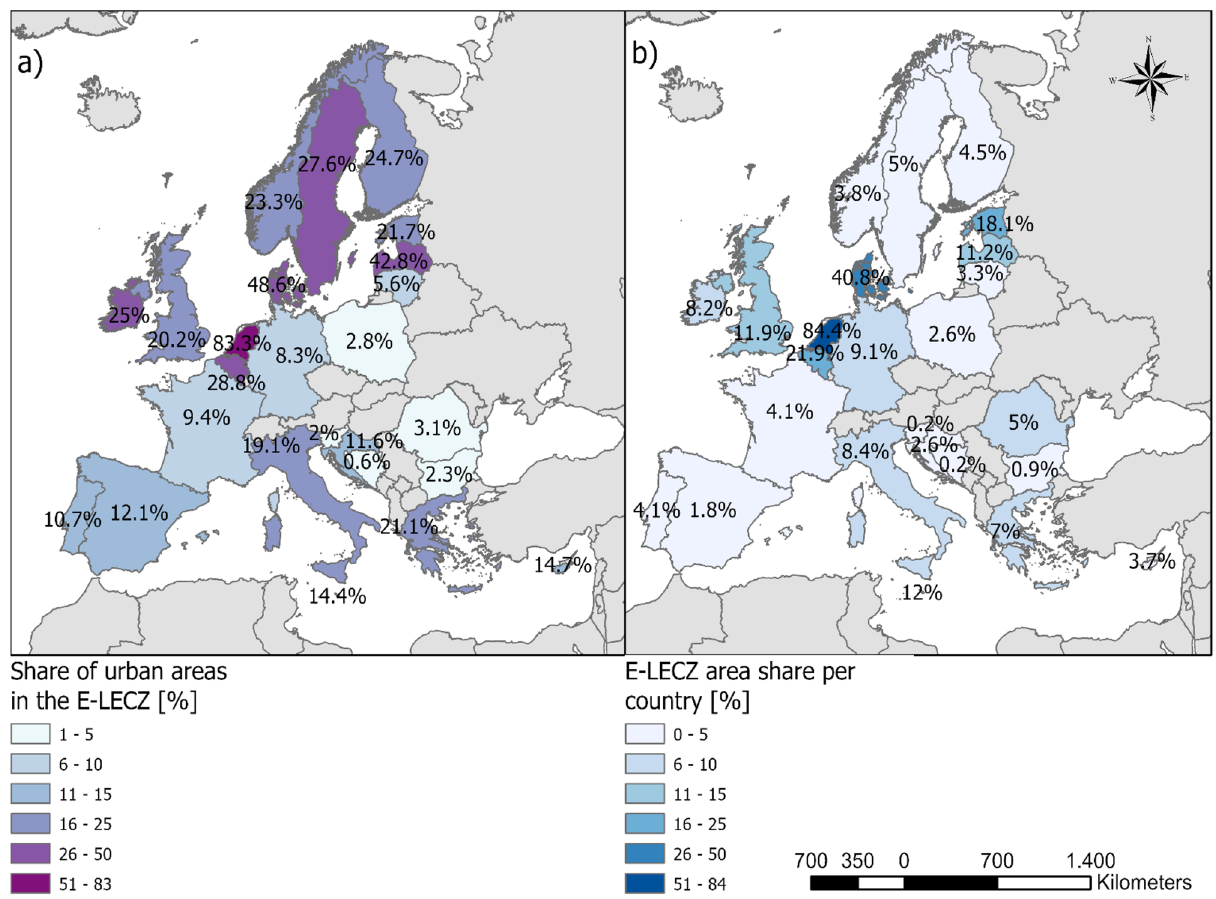
Figure 1. Coastal EU member states’ (plus BIH, GBR, and NOR) ( a ) share of urban areas in the E-LECZ [based on CORINE2012] and ( b ) share of the E-LECZ area [based on MERIT]. Darker colors indicate higher percentages. Grey countries are not included in the